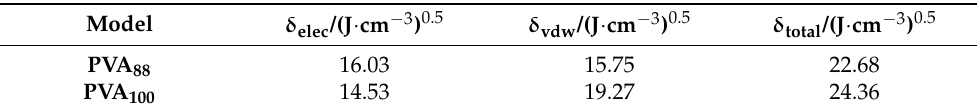
Table 7. Solubility parameter components and total solubility parameters of PVA with two alcoholysis degrees at 298.15